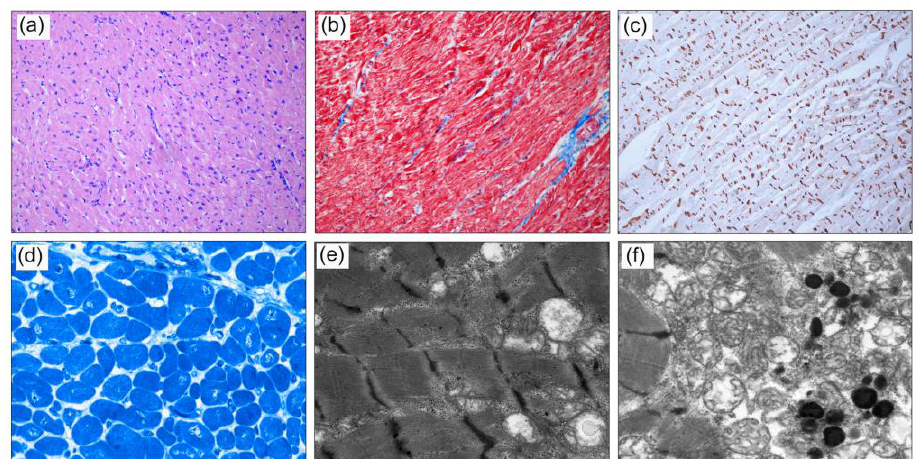
Figure 1. Histology of the left ventricle of the explanted heart from patient A.III.2: ( a ) H&E-stained sections show moderate myocardial cellular hypertrophy. ( b ) Mild myocardial fibrosis (blue) is visualized with Masson Trichrome. ( c ) Immunohistochemistry with antibodies against N-Cadherin shows focal irregularity of the intercalated disks (IDs) in longitudinal sections. ( d ) On Richardson’s- stained resin sections, increased variation of cardiomyocytes and enlarged nuclei, partly with irregular shape, are present. ( e ) Representative TEM images showing disarrangement of myofibril architecture and sarcomere structure, with focal diminished and thickened Z-Bands. ( f ) Mitochondria are located in aggregates with swollen and dissolved cristae between myofibrils with occurrence of lipofuscin (Magnification ( a – c ) x100, ( d ) x400, ( e , f ) x12,000).